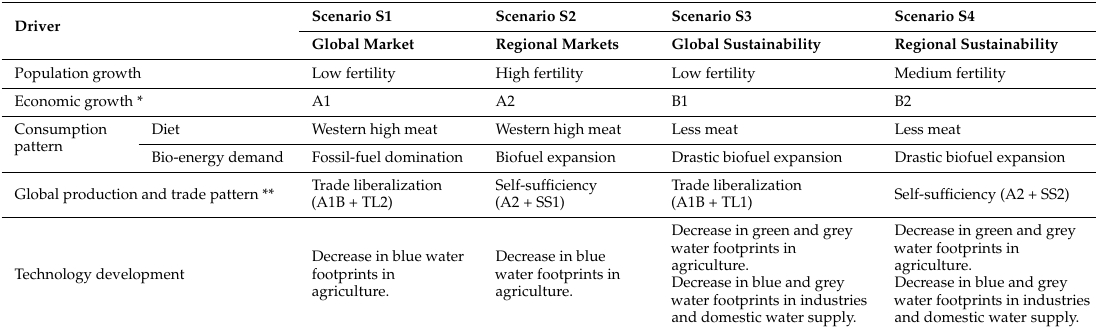
Table 1. Drivers and assumptions per scenario (from Ercin and Hoekstra,